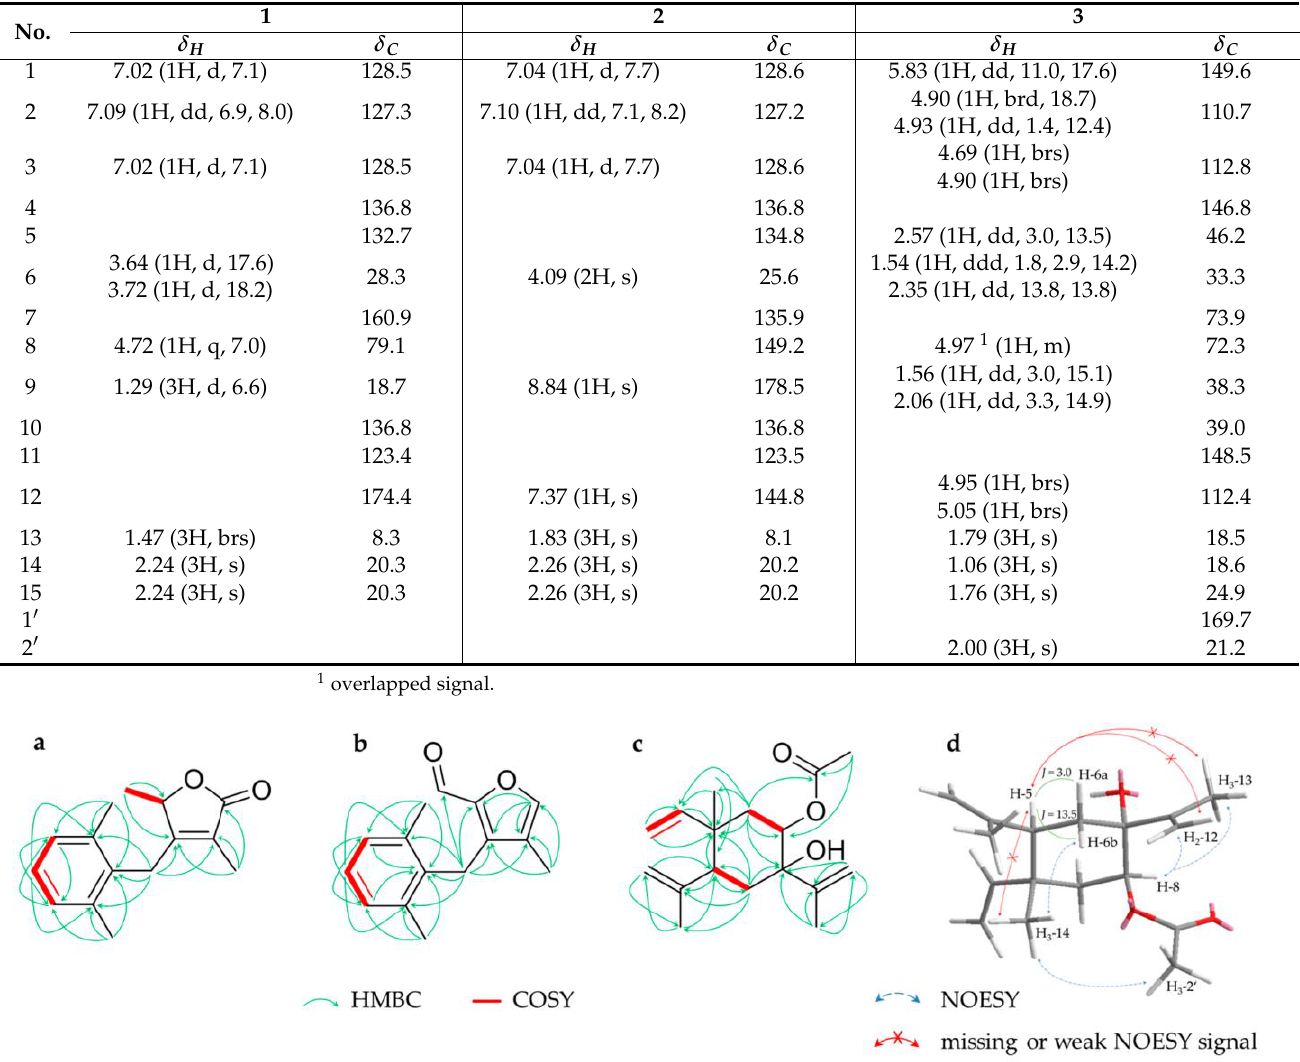
Table 1. 1 H and 13 C NMR data for compounds 1 – 3 (600 and 150 MHz, respectively) in CDCl 3 ( δ in ppm, J in Hz, s: singlet, d: doublet, br: broad, and m: multiplet).